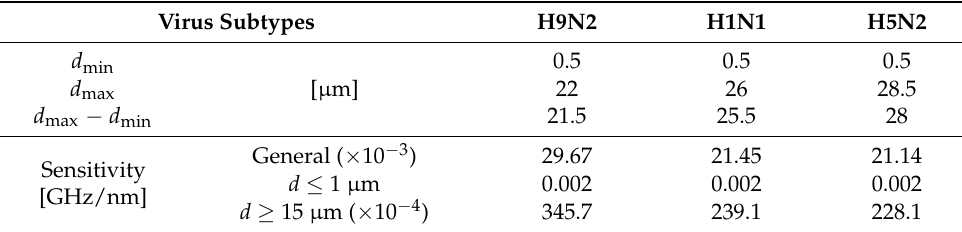
Table 6. Numerical representation of sensitivity parameters around the second peak for CrossPMA. Minimal absorption is declared at 50% of the absorption value of the unloaded